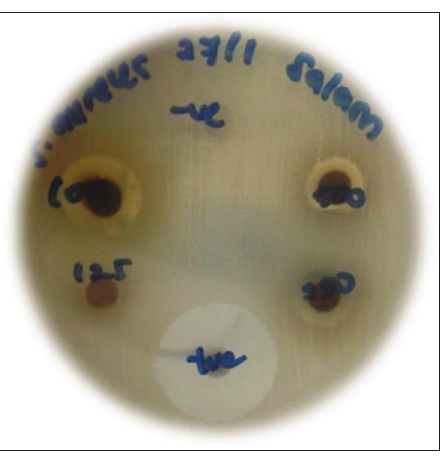
Figure-2: Growth zone of inhibition of some of the bacteria ( Staphylococcus aureus ) caused by Syzygium polyanthum extract.